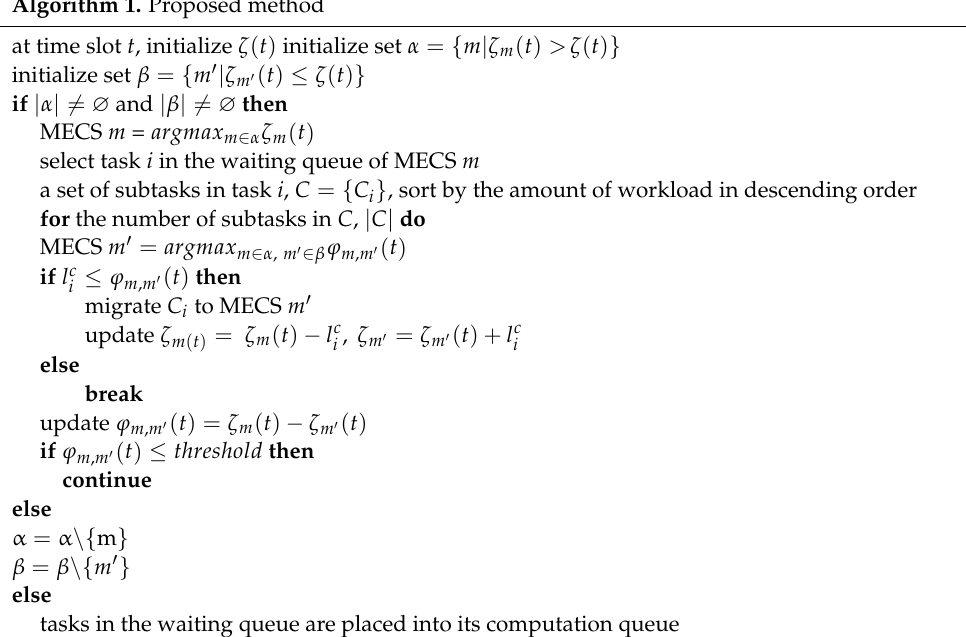
Algorithm 1. Proposed